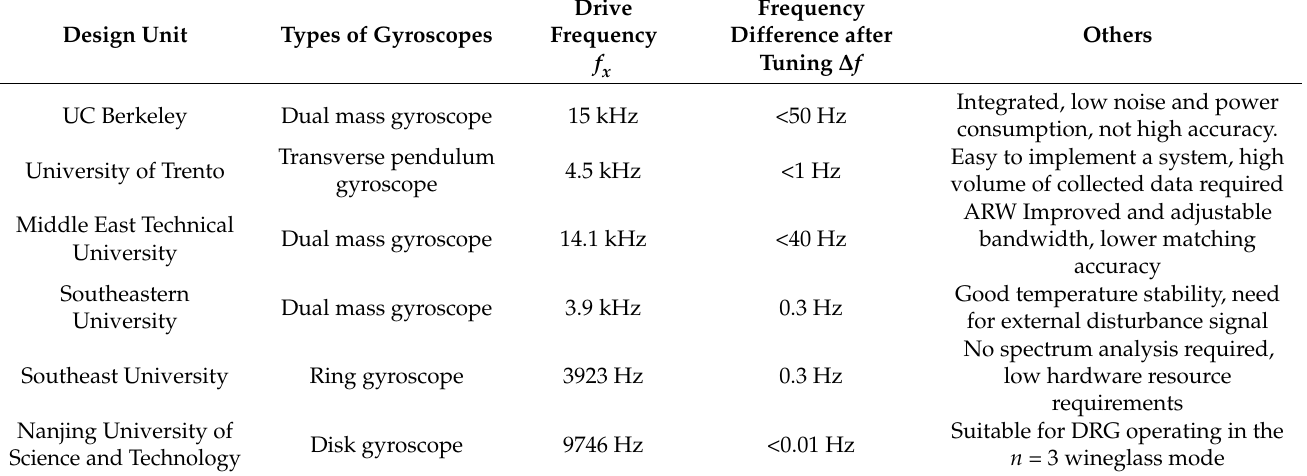
Table 3. Comparison of electrostatic tuning schemes with amplitude as